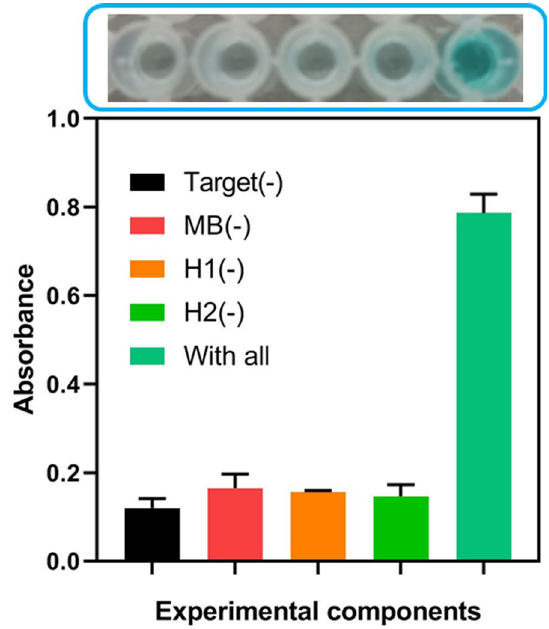
Fig. 3 Absorbance and the colorimetric assay when essential experimental components (target, MB, H1, and H2) existed or